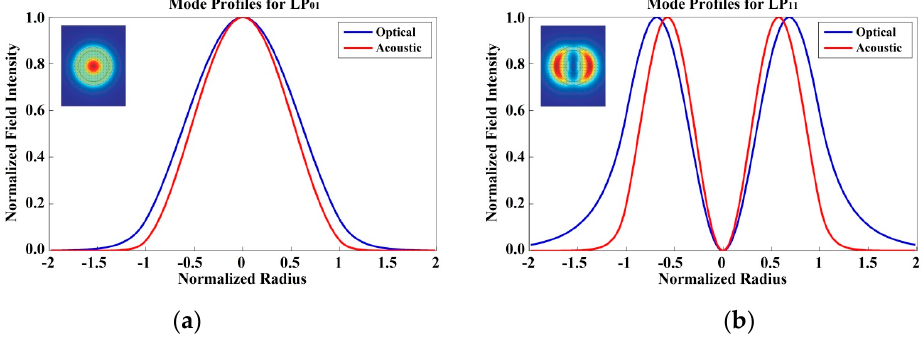
Figure 10. The intensity profiles of optical/acoustic modes for LP 01/11 in a FMF.